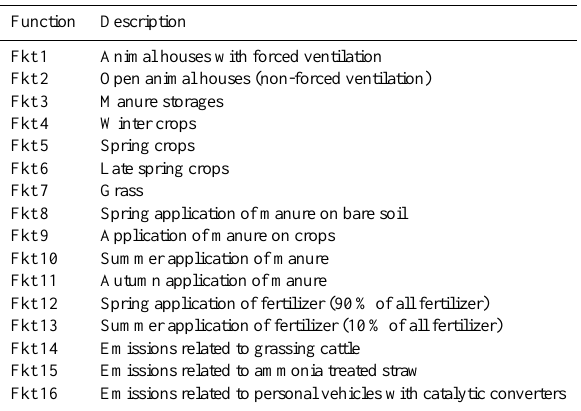
Table 2. A short description of the 16 different functions describ- ing the temporal variation in NH 3 emissions from various activities (similar to Table 1 in Skjøth et al.,